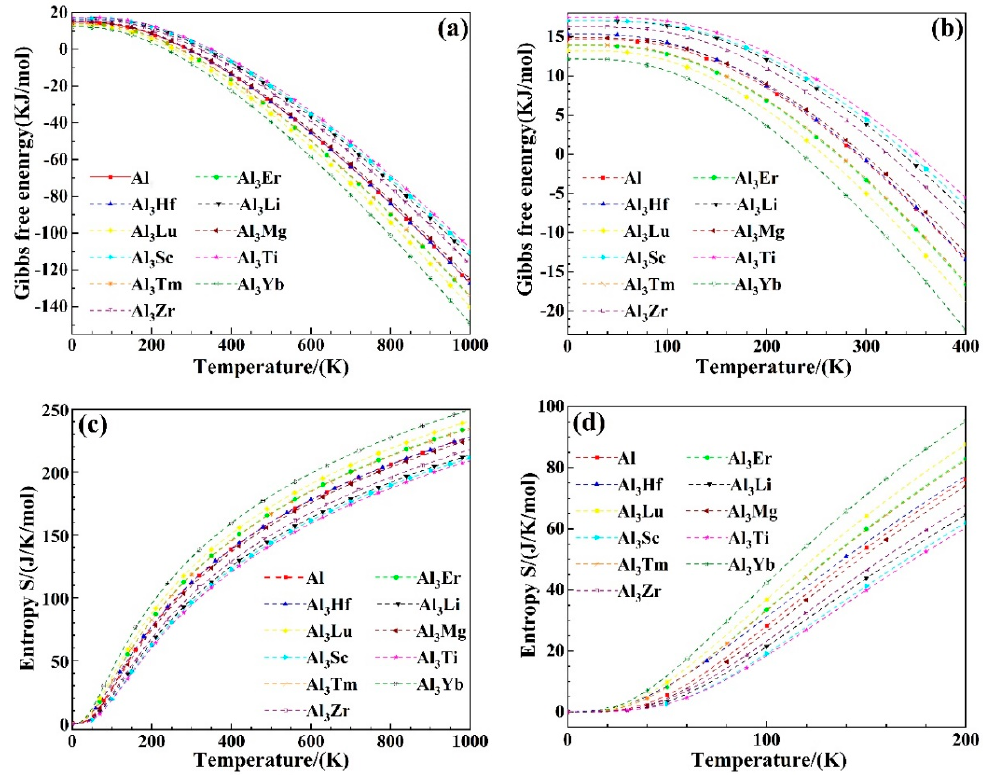
Figure 1. The calculated temperature dependence of ( a ) the Gibbs free energy and ( c ) the entropy of pure Al and L1 2 -Al 3 M structures, where ( b , d ) represent this dependence, are limited to the specific temperature range of 0–400 K and 0–200 K, respectively.